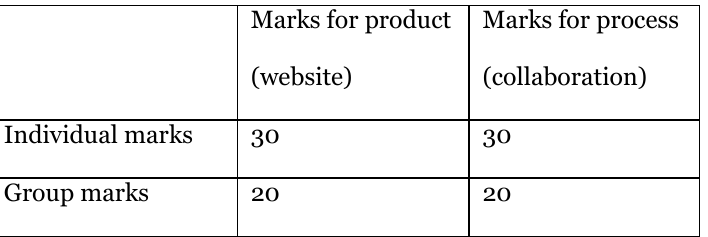
Proportion of Marks Allocated to Product and Process and on a Group and Individual Basis Marks for product Marks for process (website) (collaboration) Individual marks 30 30 Group marks 20